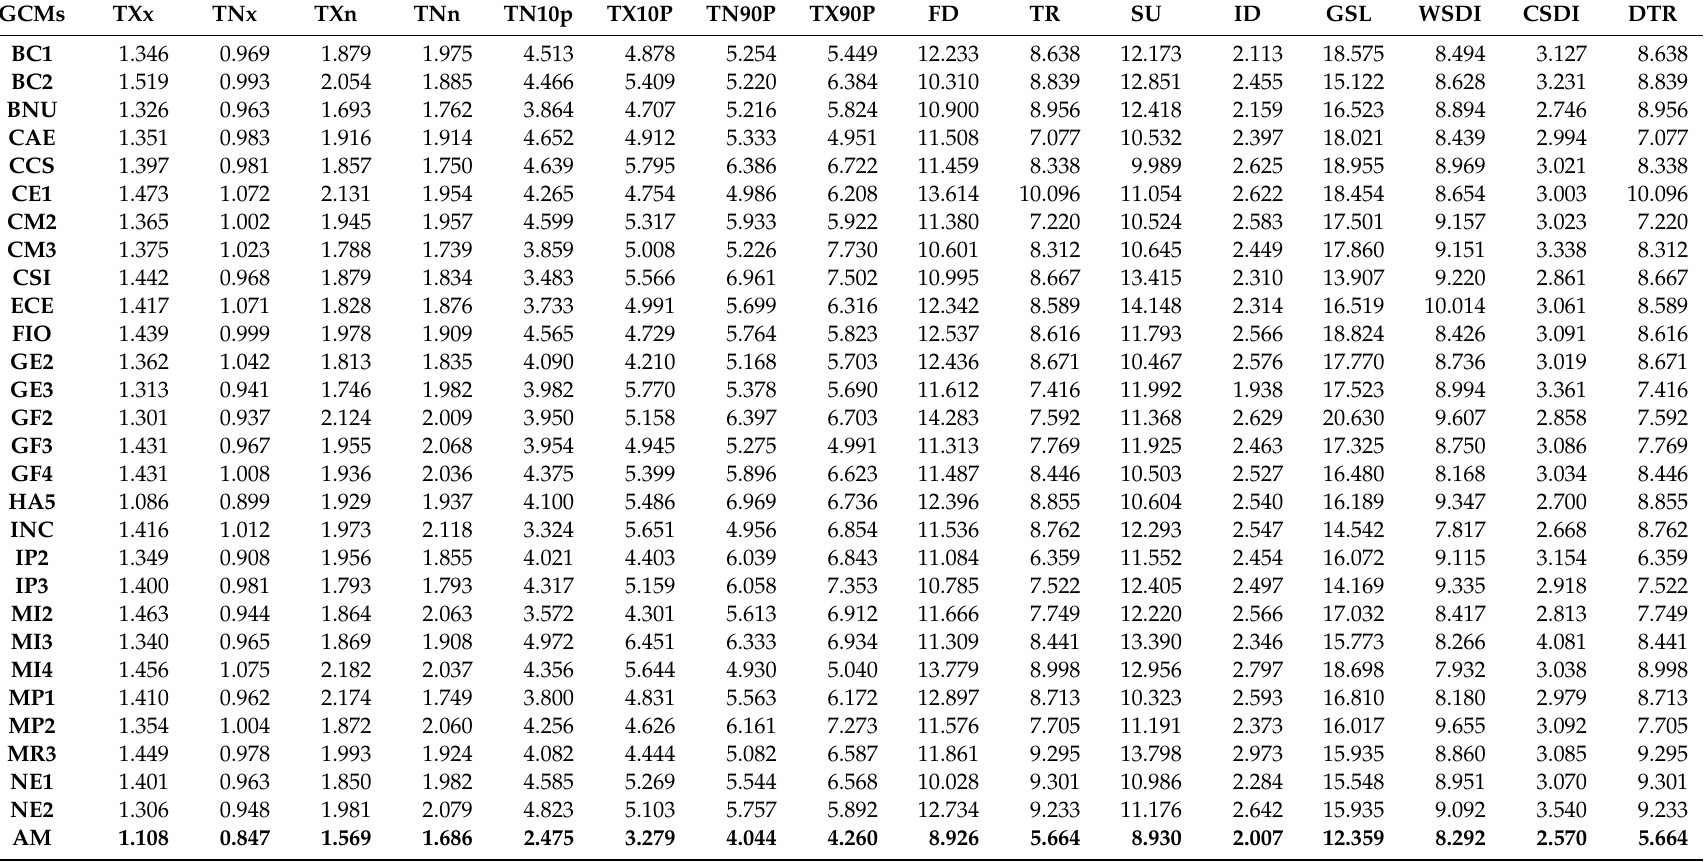
Table 3. Root mean square error (RMSE) between the muti-model arithmetic mean for each GCM and observed values for the 16 temperature indices during